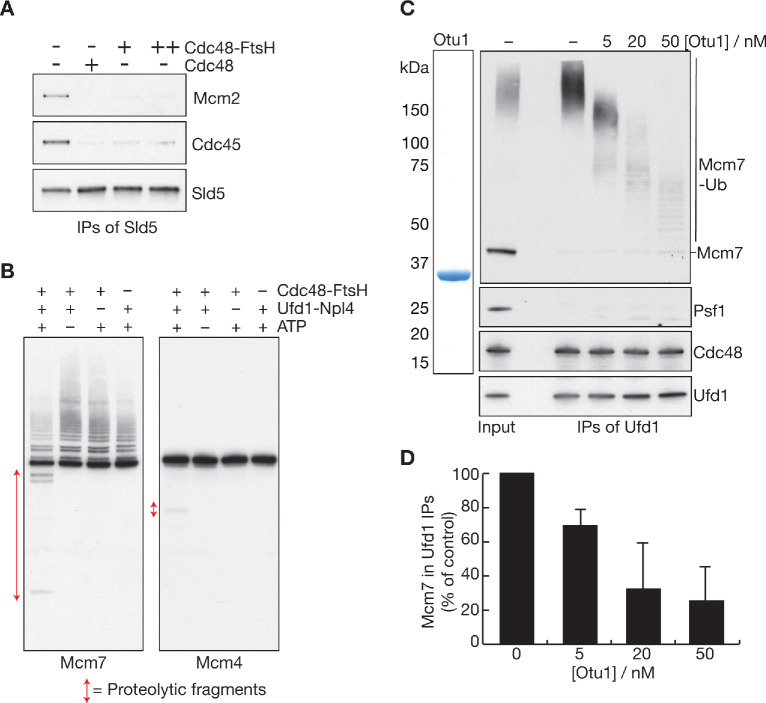
Ubiquitylated Mcm7 is unfolded during CMG helicase disassembly, and the ubiquitin chains must then be cleaved in order to release unfolded Mcm7 from Cdc48-Ufd1-Npl4.(A) CMG was ubiquitylated as in Figure 4, before incubation 20’ at 30°C with the indicated factors. Ufd1-Npl4 was included in each case. Cdc48 and Cdc48-FtsH were included at 50 nM (+) or 200 nM (++). At the end of the reactions, the integrity of CMG was monitored by immunoprecipitation of Sld5. (B) Analogous CMG disassembly reactions to those in Figure 5D were performed in the presence of the indicated factors. At the end of the reactions, samples were incubated with HsUSP2, and cleavage of ubiquitylated Mcm4 and Mcm7 by Cdc48-FtsH was then detected by immunoblotting. (C) CMG disassembly was performed as in Figure 4A–B, before incubation with the indicated concentrations of the deubiquitylase Otu1 for 30’ at 30°C. Release of unfolded Mcm7 from Cdc48-Ufd1-Npl4 was then monitored by immunoprecipitation of Ufd1. (D) Quantification of the data in (C). The experiment was repeated three times, and the figure presents the mean values with standard deviations.